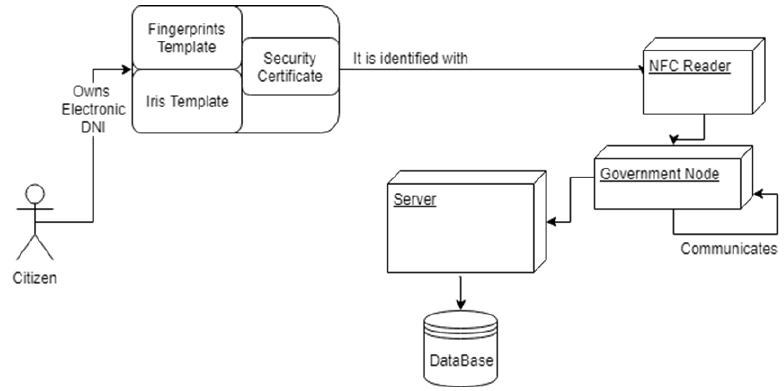
Figure 3. Block diagram of a node in the proposed network